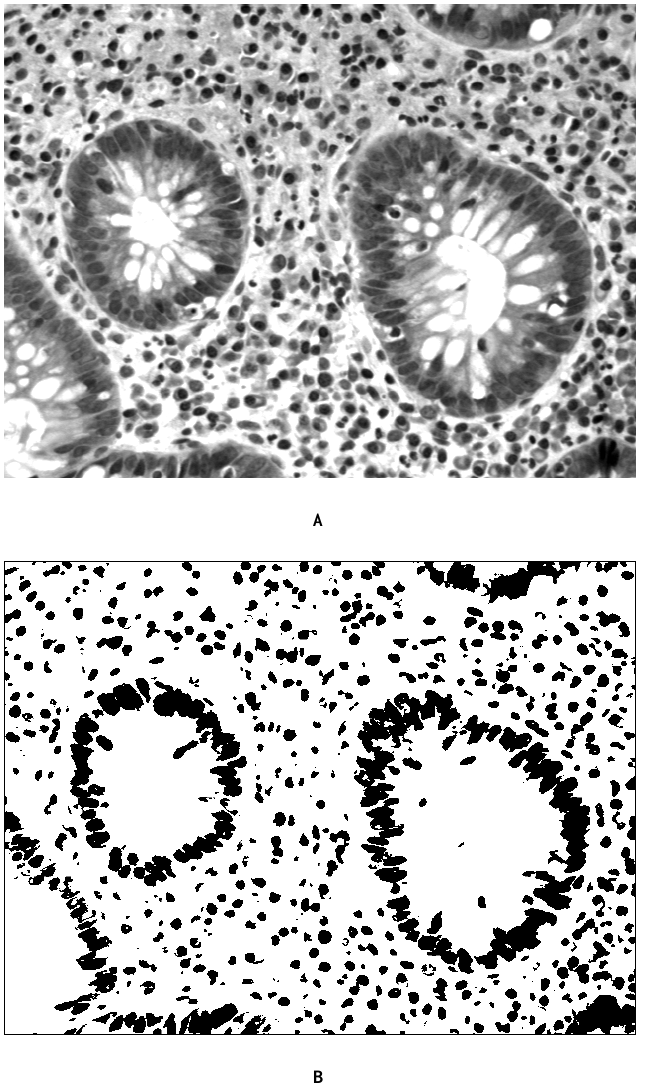
FIGURE 1 . (A) A typical image of small intestine glands. There are two complete glands in the middle and four partial ones at the image borders. (B) A threshold segmentation separating the regions of cells in both groups from the